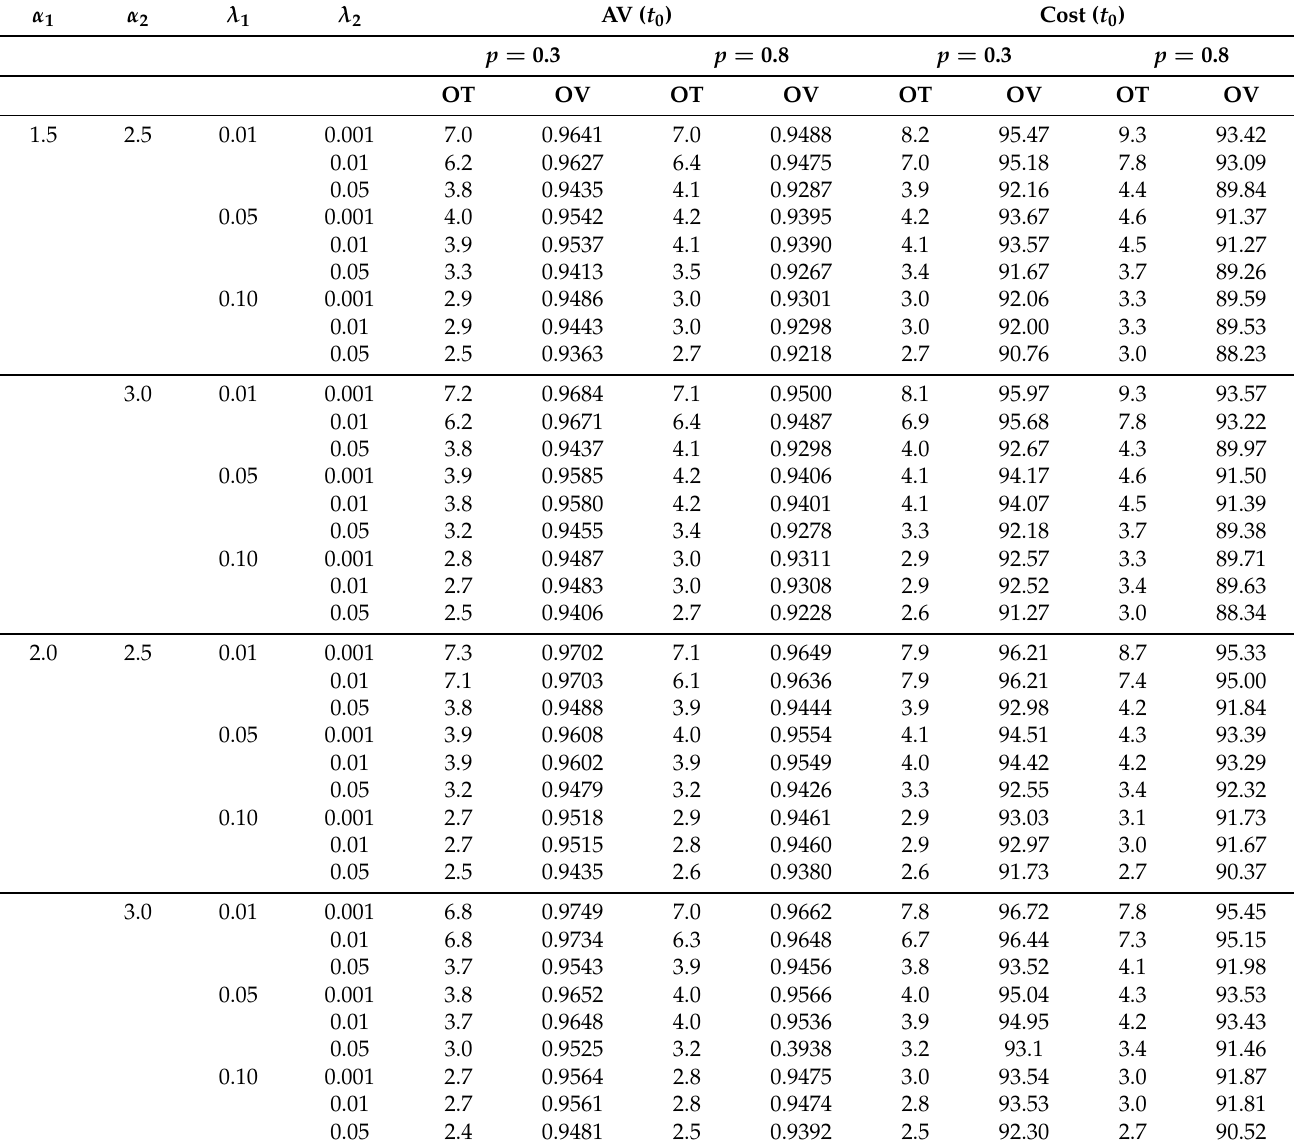
Table 2. The optimal time (OT) and optimal value (OV) of the availability and cost function of the system in the steady state when ν = 0.5, δ = 1, λ 3 = 0.3, λ 4 =